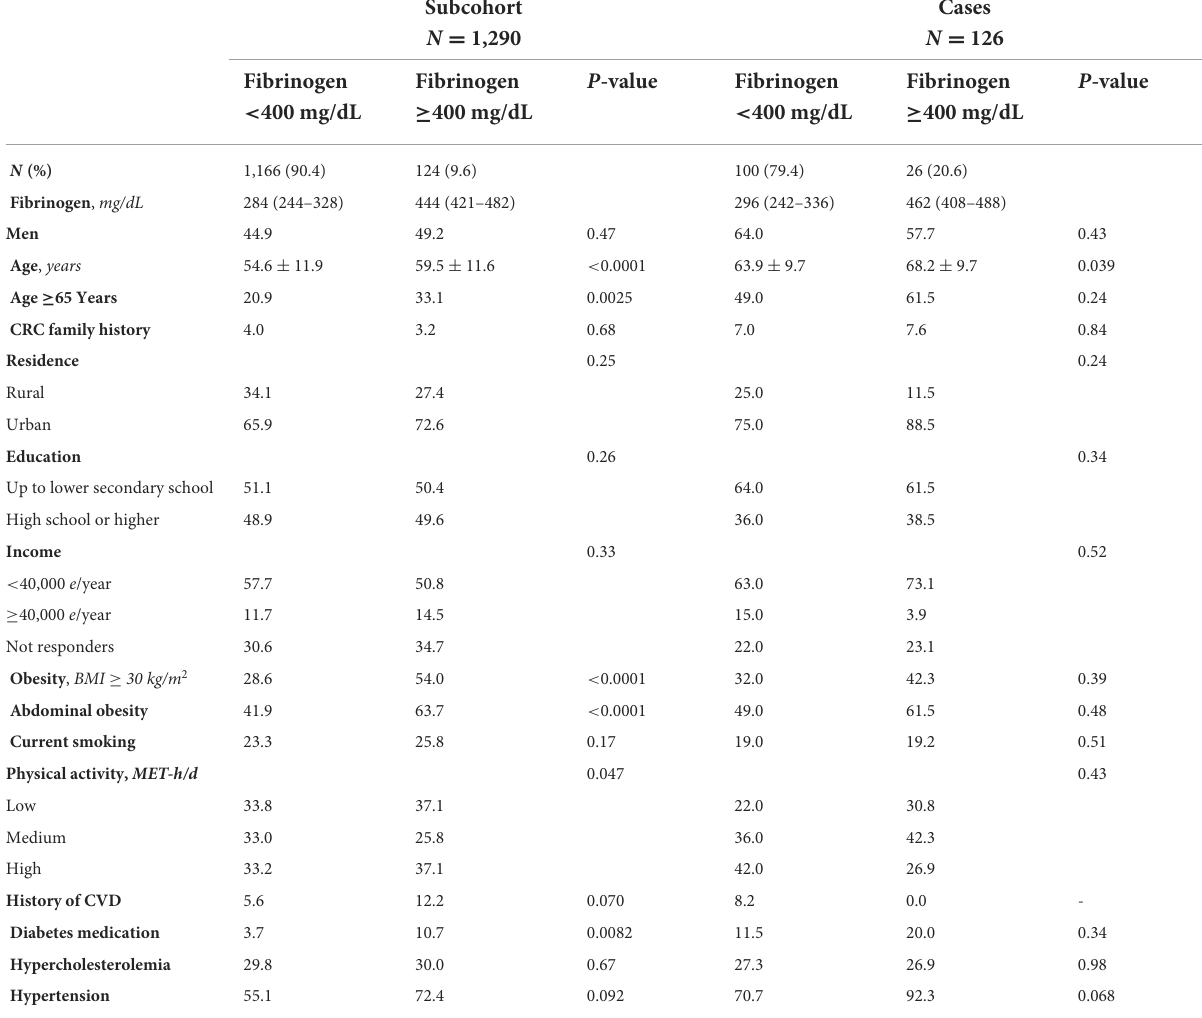
TABLE 1 Baseline characteristics in the subcohort ( N = 1,290) and cases ( N = 126) according to levels of fibrinogen < or ≥ 400 mg/dL.